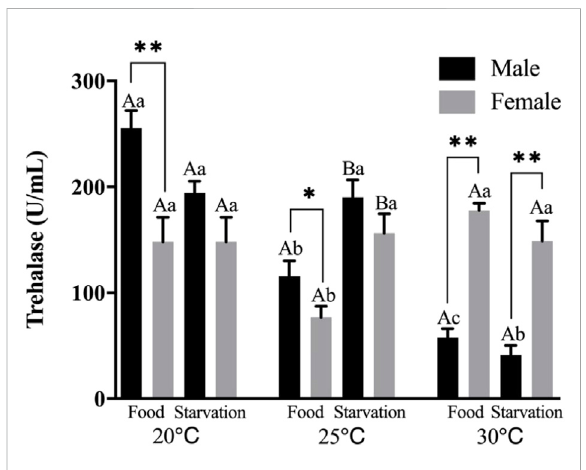
FIGURE 6 Trehalase (THL) of different sex M. coruscus exposed to six combinations of temperature (20, 25, and 30 ° C) and the feeding condition (food and starvation) at 30 days during the exposure period.Differentcapitallettersindicatesigni fi cantdifferences between the feeding condition and each temperature levels (20, 25, and 30 ° C) ( p < 0.05). Different small letters indicate signi fi cant differences between temperature (20, 25, and 30 ° C) and the same feeding condition ( p < 0.05). Asterisk indicates signi fi cant differences between sex and each feeding condition, in which * representssigni fi cantdifference( p < 0.05)and**representshighly signi fi cant difference ( p < 0.01).